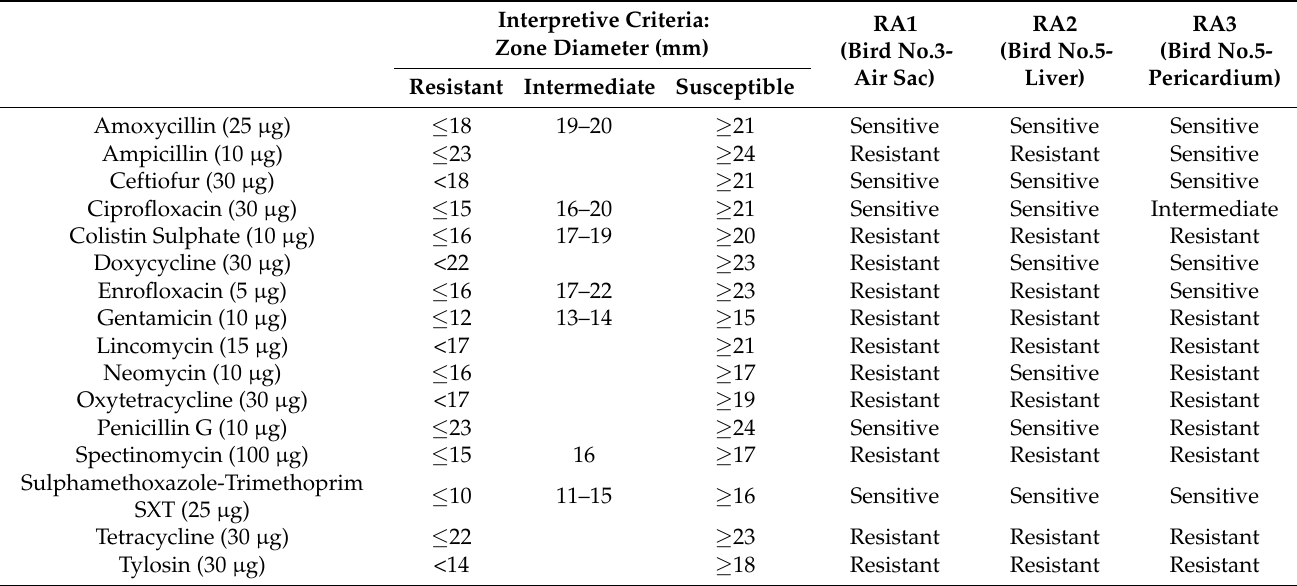
Table 2. Resistance breakpoints and antibiotic sensitivity pattern of Riemerella anatipestifer from broiler chicken tissues.